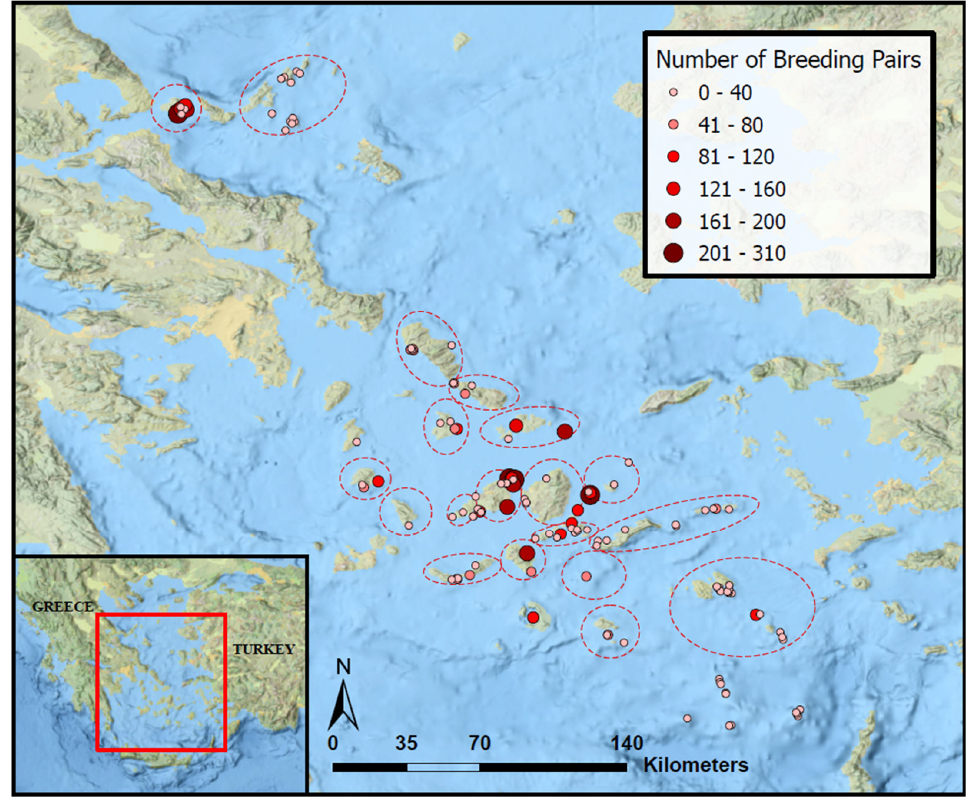
Figure 2. Locations and sizes (number of breeding pairs) of sampled L. michahellis colony sites located in the Aegean Sea. Regional boundaries are shown with dashed red lines and have been simplified for effective viewing. Base map sources: Esri, USGS, HERE, Garmin, FAO, NOAA, CGIAR.